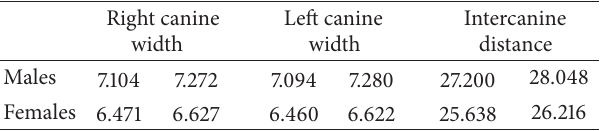
Table 3: 95% confidence interval of canine width and intercanine distance in males and females. Right canine Left canine Intercanine width width distance Males 7.104 7.272 7.094 7.280 27.200 28.048 Females 6.471 6.627 6.460 6.622 25.638